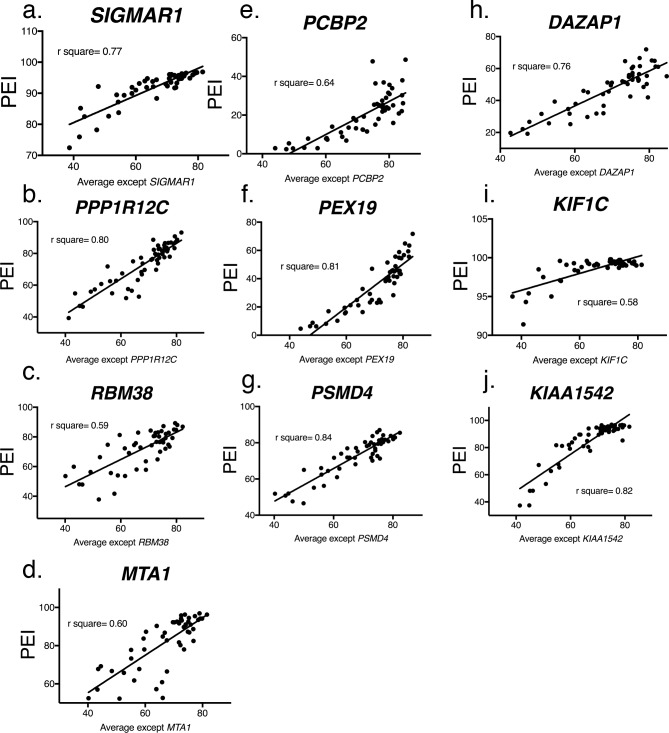
Linear regression of hnRNP H enhanced exons.(a–j) Linear regression all remaining genes not shown in Figure 2a. Percent exon inclusion (PEI) for each hnRNP H-target exon is plotted as a Y-coordinate compared to the average percent inclusion of all other hnRNP H-enhanced exons. R-square values are displayed.